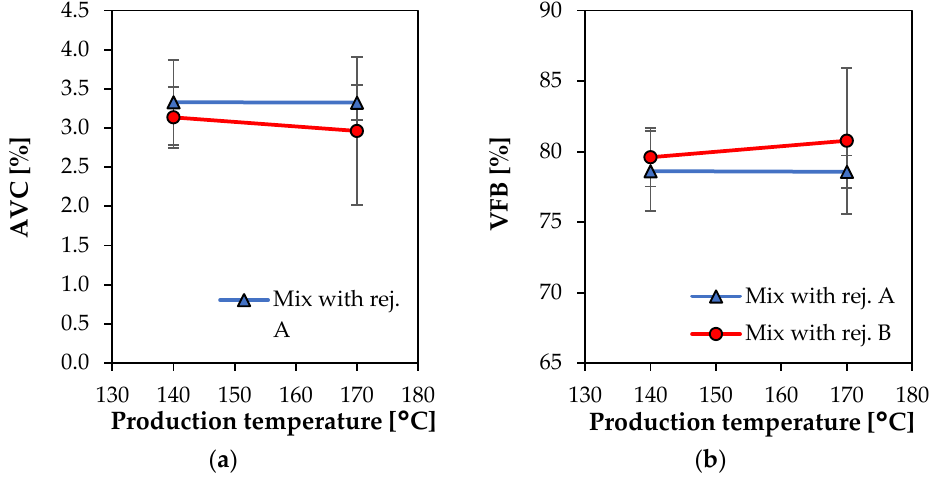
Figure 3. Volumetric properties of the mixtures: ( a ) Air voids content; ( b ) Voids filled with bitumen.